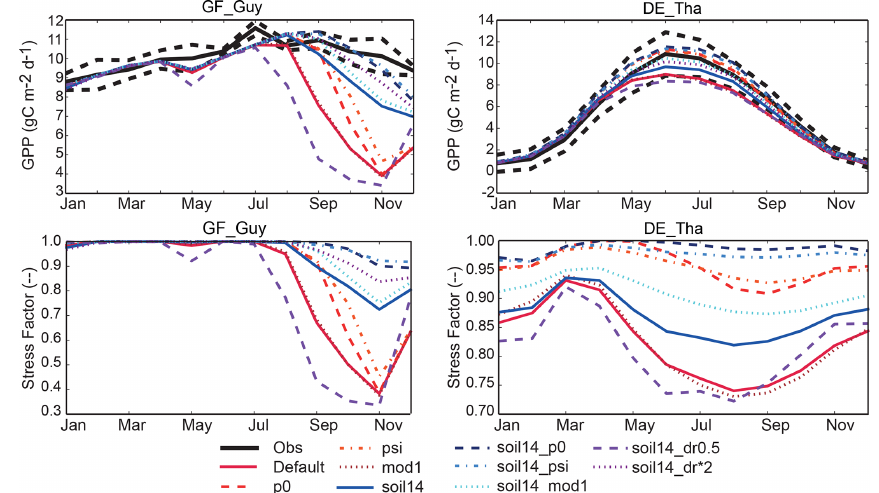
Figure 8. Example of impacts of changes to the representation of soil moisture stress (see Table 1) on simulated seasonal cycle of GPP at two soil-moisture-stressed sites (see Sect. 3.3; similar examples for BE-Vie and CA-Oas are given in Fig. S9a). The GF-Guy simulations included the years 2007–2009, and the DE-Tha simulations included the years 1996–2014. GF-Guy is a tropical evergreen broadleaf forest and DE-Tha is an evergreen needleleaf forest. Details of the simulations are provided in Sect. 2.3 and Tables